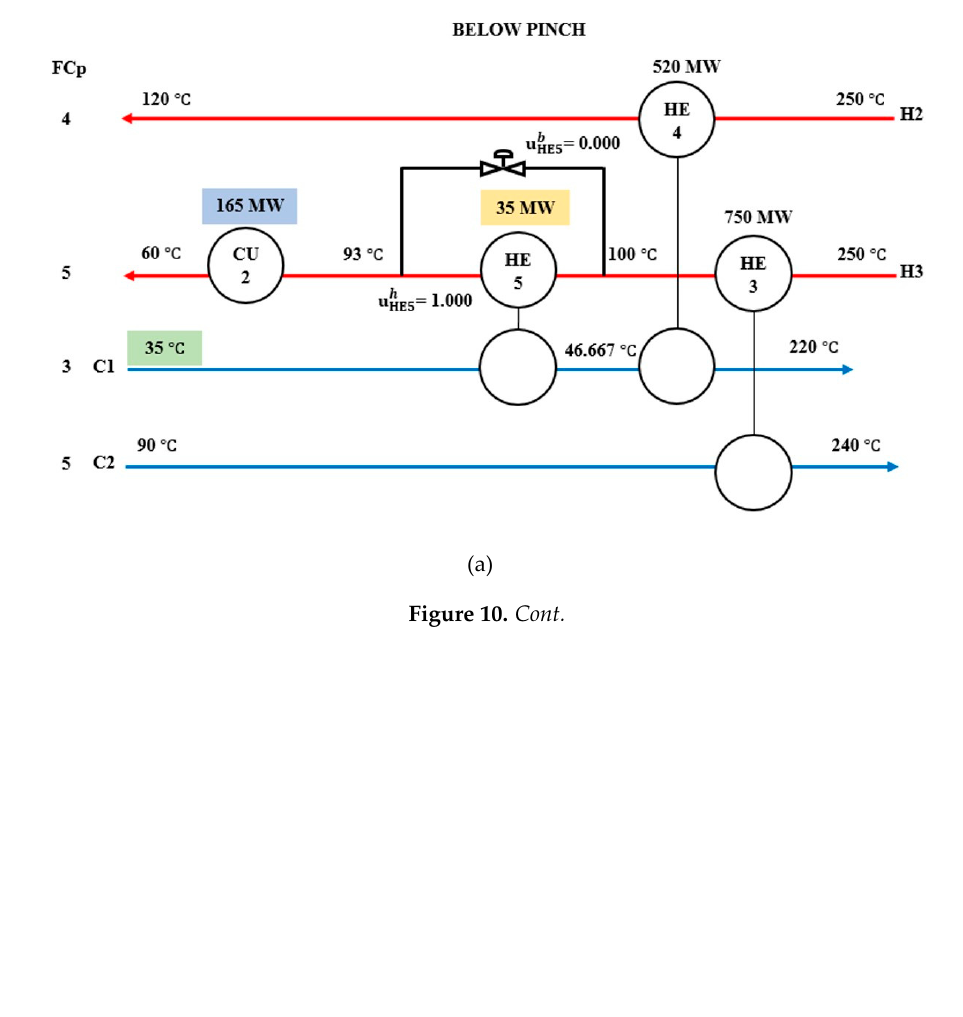
Figure 9. ( a ) The plus-minus principle with T S decreased by 5 ℃ for C1; ( b ) the plus-minus principle of nominal T S for C1; ( c ) The plus-minus principle with T S increased by 5 ℃ for C1.